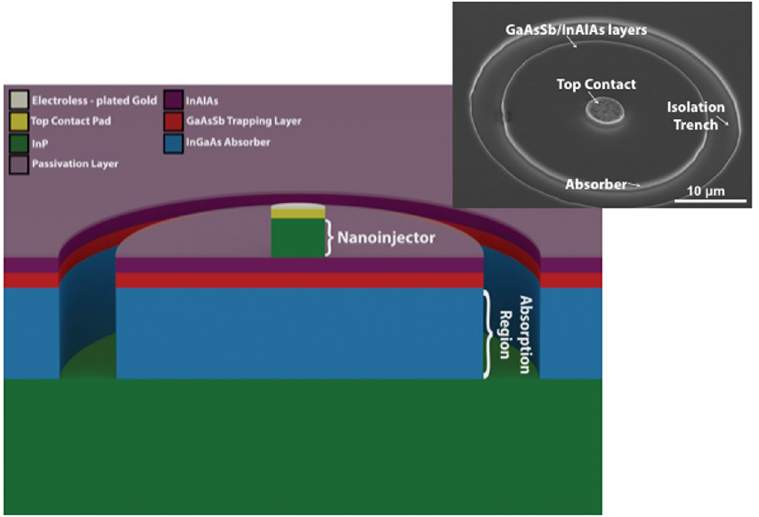
Figure 6. ( a ) Schematic diagram of passivated electron-injection detector with 5 μ m injector diameter and 30 μ m absorber diameter. The scanning electron microscope image is taken before passivation and electroless